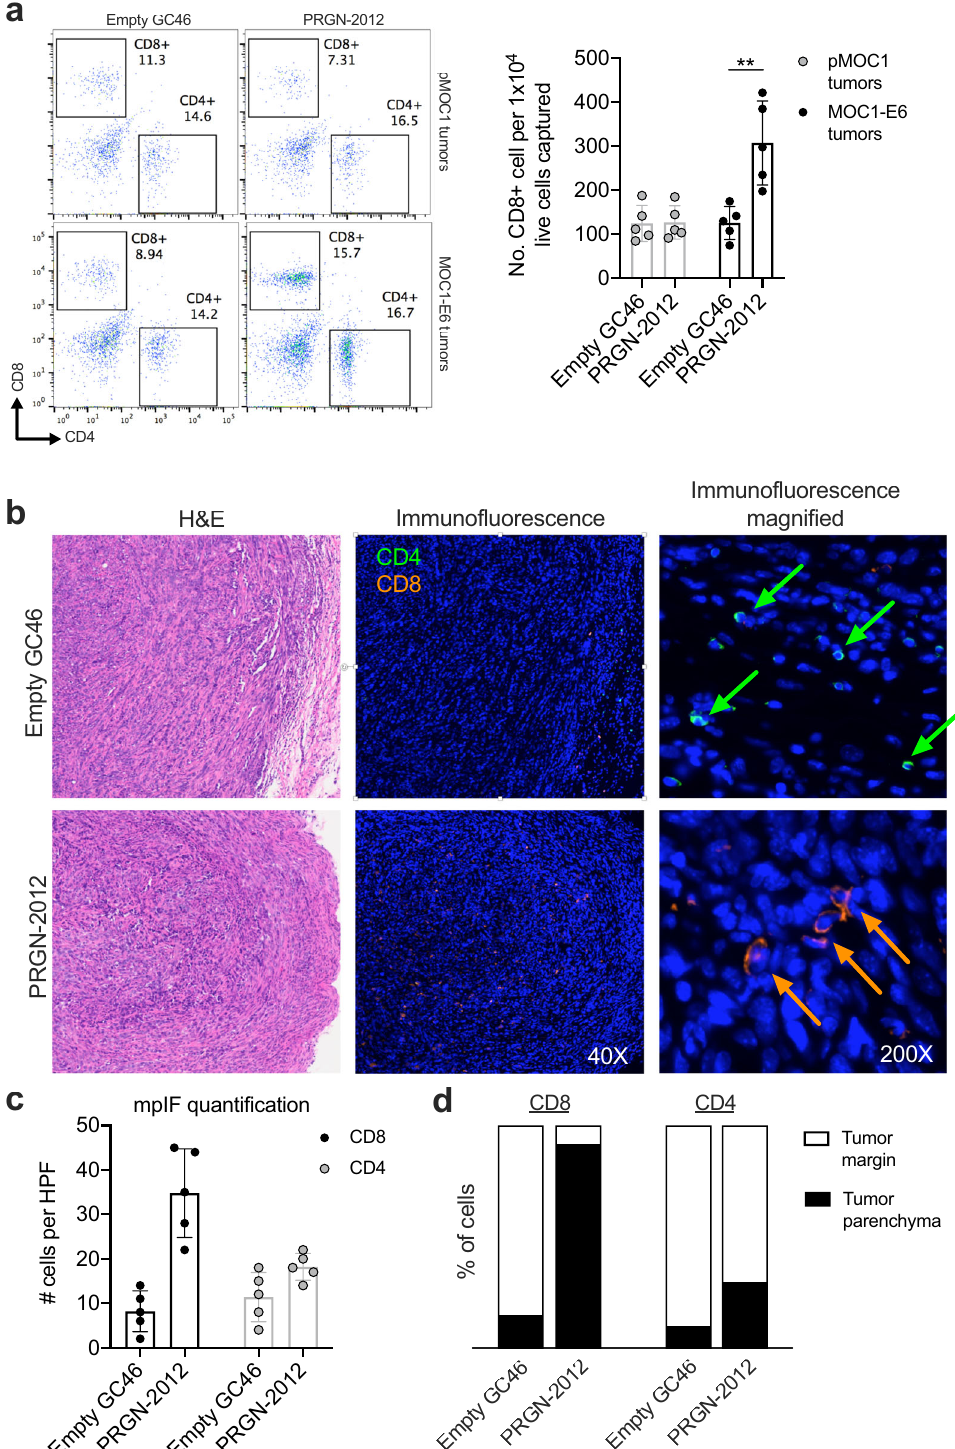
Fig. 5 PRGN-2012 promoted traf fi cking of CD8 + T lymphocytes into the tumor parenchyma. a Representative dot plots of freshly digested parental pMOC1 or MOC1-E6 tumors obtained from mice treated with PRGN-2012 or empty GC46 assessed for T-lymphocyte accumulation via fl ow cytometry. Normalized quanti fi cation is shown on the right. b Representative H&E and immuno fl uorescence photomicrographs demonstrating localization of T lymphocytes within MOC1-E6 tumors treated with PRGN-2012 or empty GC46. c Quanti fi cation of total T lymphocytes per high power fi eld (HPF). mpIF multiplex immuno fl uorescence. d Quanti fi cation of tumor margin vs tumor parenchyma localization of CD8 + and CD4 + T